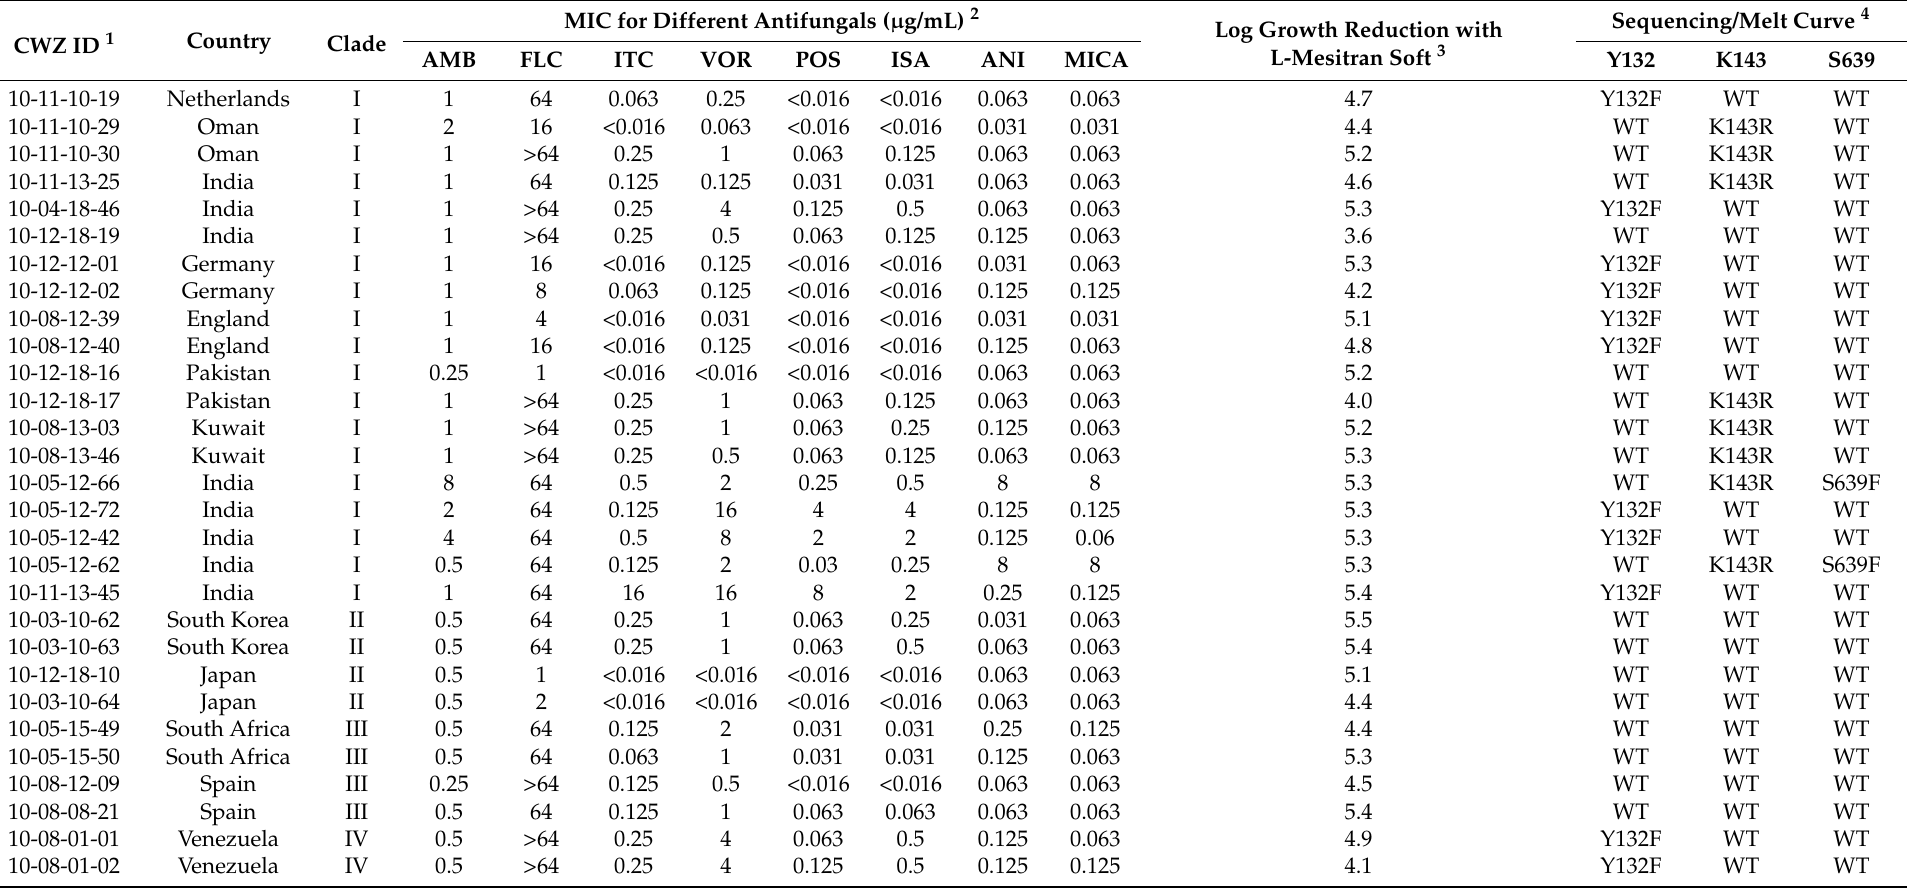
Table 1. Overview susceptibility of clinical C. auris isolates with the corresponding